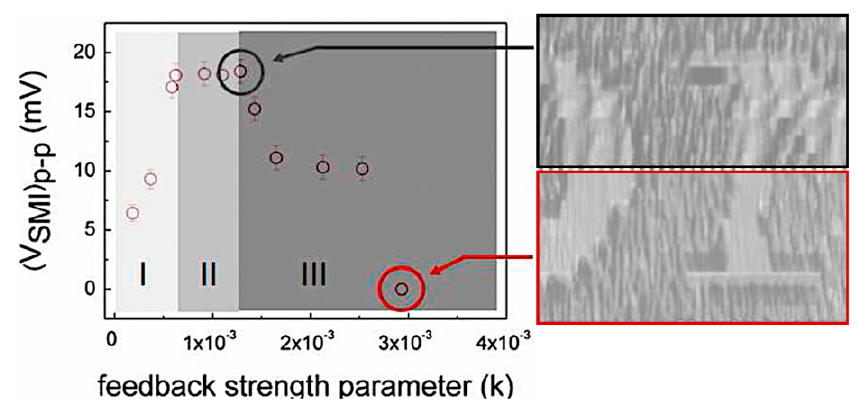
Figure 9. Left panel: fringe amplitude dependence on feedback level, expressed in term of the κ -parameter. Right panel: at low feedback level (upper half) OF fringes are clearly distinguishable superposed to the index contrast image, due to surface misalignment from the optic axis. At large feedback level (lower half) the OF signal loses phase information of the reflected beam and is defined by the feedback power only (adapted from Reference [43]).